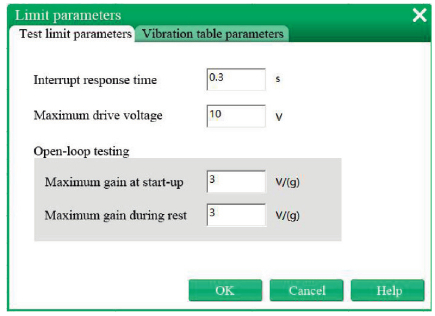
Figure 23: Setting the test limit parameters.